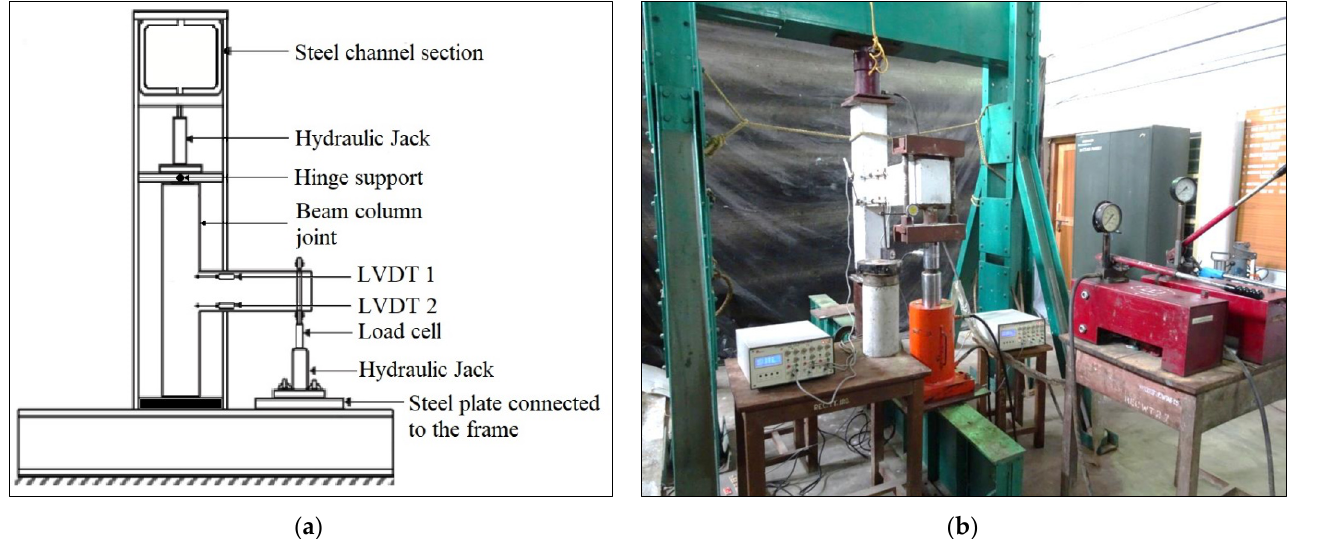
Figure 4. ( a ) Schematic diagram of the test setup and ( b ) experimental test